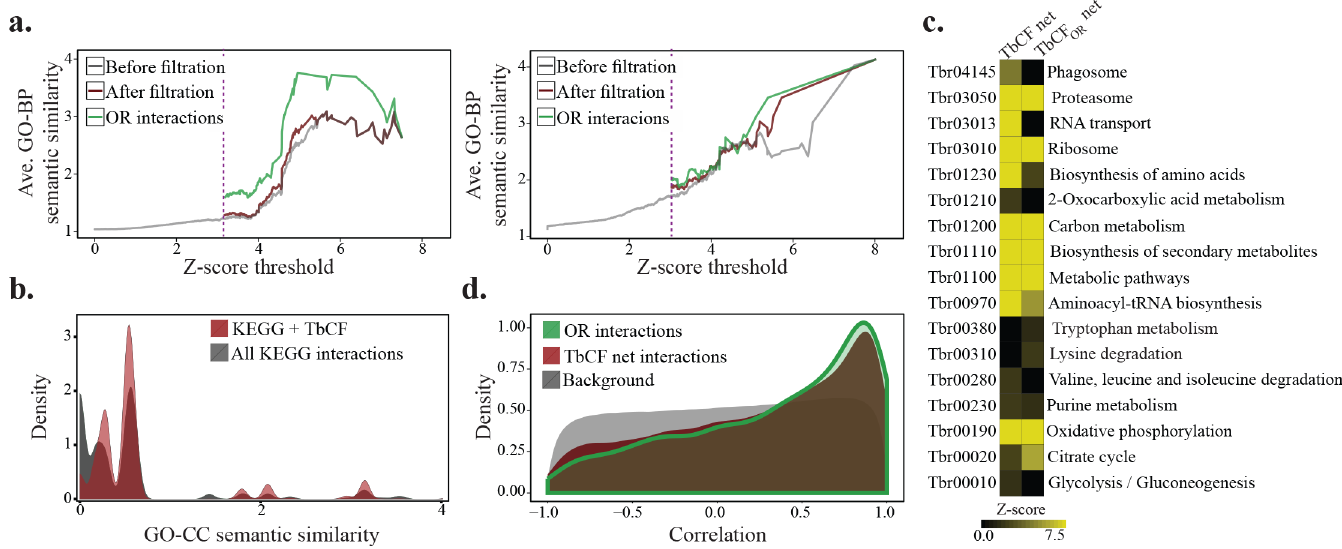
Fig 5. Biological validation of the constructed co-fractionation network. a) The average GO-BP semantic similarity was calculated across different z- score cut-off thresholds for whole cell-GG and mitochondrial-GG experiments, separately. The purple line highlights the co-sedimentation cut-off threshold corresponding to a false discovery rate of 0.05. To examine the applied filtration steps (elimination of noise sensitive, unshared-peak, early sedimenting, and non-reproducible interactions), we applied the same analysis to whole cell-GG and mitochondrial-GG networks before and after the filtration steps. As shown, the employed filtration steps have led to an increase in precision in both networks. However, the reproducible interactions constantly had higher similarity compared to the non-reproducible interactions. b) GO-CC semantic similarity distribution of all possible protein pairs with the same KEGG pathway was compared with the distribution of those KEGG interactions that were also supported by TbCF net. As illustrated, protein pairs in the latter group have significantly higher (p-value < 3.5e-33, Wilcoxon-Mann-Whitney rank sum test) co-localization scores compared to the all functional interactions supported by KEGG. c) KEGG pathway modulation analysis of TbCF and TbCF OR networks. The graph is pseudo-colored where the yellow color indicates significant connections (p-value < 0.05) among proteins in the corresponding KEGG pathway. d) Distribution of observed co-expression similarities among all proteins detected in our study (background), protein pairs interacting in TbCF net, and those in TbCF OR net. Gene expression data were extracted from [50]. A more comprehensive analysis is presented in S8 Fig. OR interactions: Orthogonally reproducible interactions; KEGG + TbCF: KEGG interactions supported by TbCF